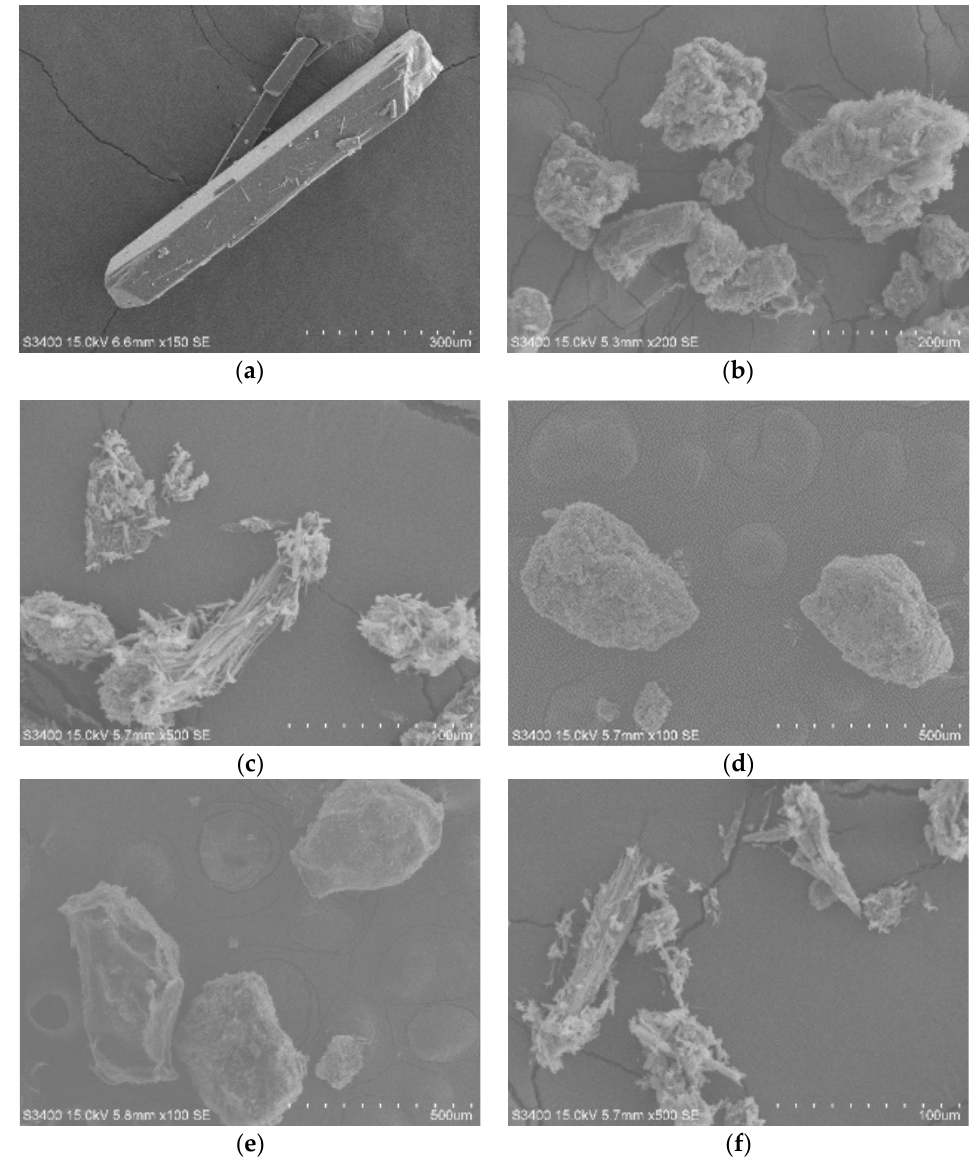
Figure 3. SEM images of famoxadone Form I ( a ), Form II ( b ), Form Ⅲ ( c ), Form Ⅳ ( d ), Form Ⅴ ( e ), and Form Ⅵ ( f ).